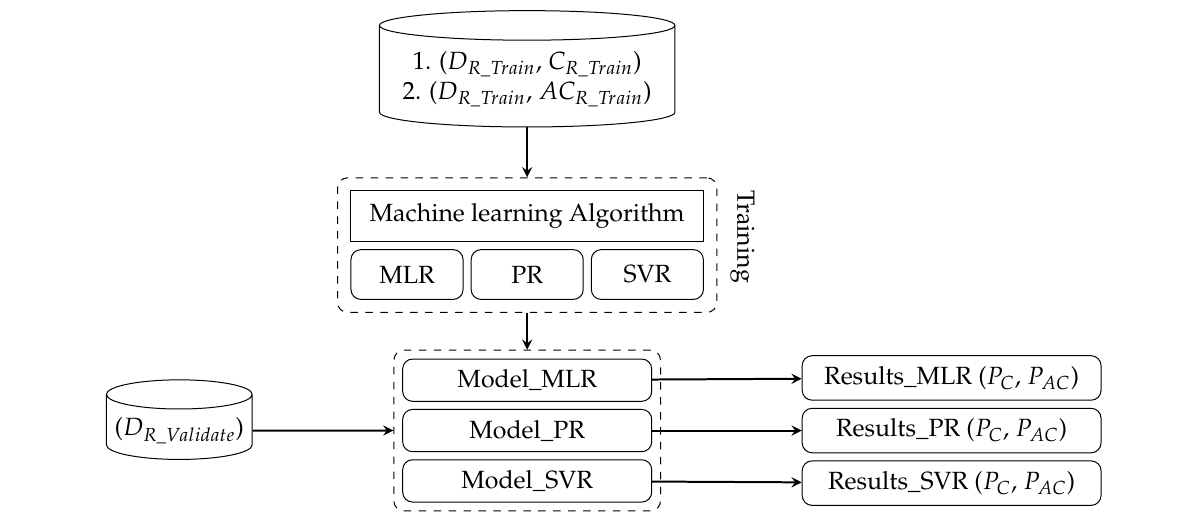
Figure 6. The process of three machine learning models.